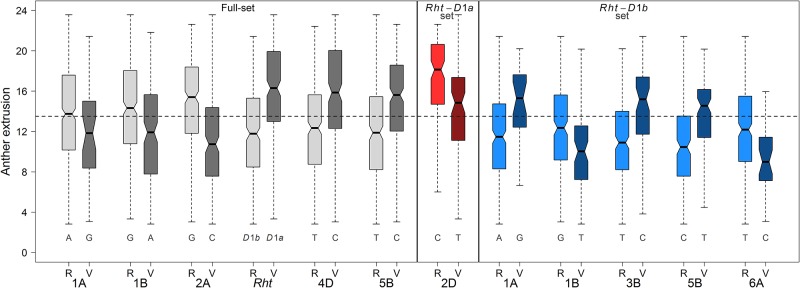
Influence of the most significant SNPs (SNPs with the largest additive effect) on AE phenotype based on GWAS conducted on panels harboring full-set of varieties and varieties harboring only Rht-D1a and Rht-D1b alleles.Horizontal dotted line marks the mean of AE BLUEs. R and V denote the varieties harboring reference (major) and variant (minor) alleles, respectively.